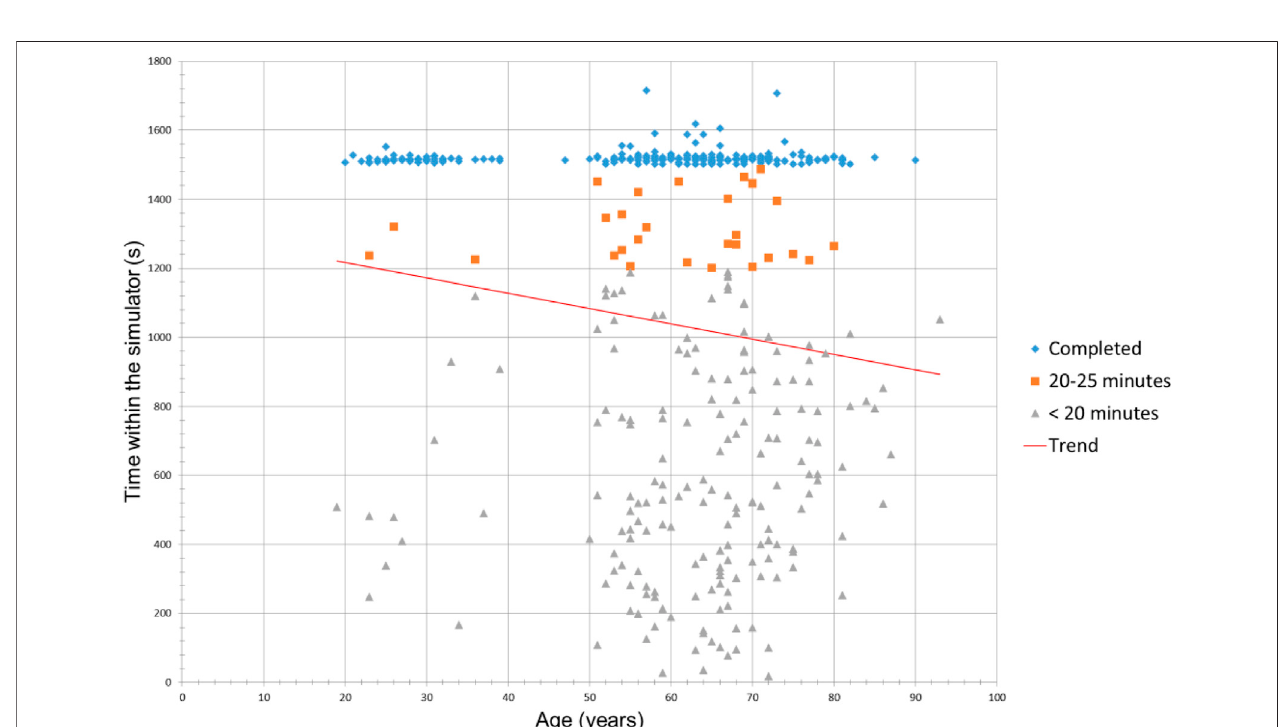
FIGURE 3 | Distribution of driving time regarding the age of participants at baseline driving (T0). Those who did not complete the baseline scenario stopped because of symptoms of simulator sickness.